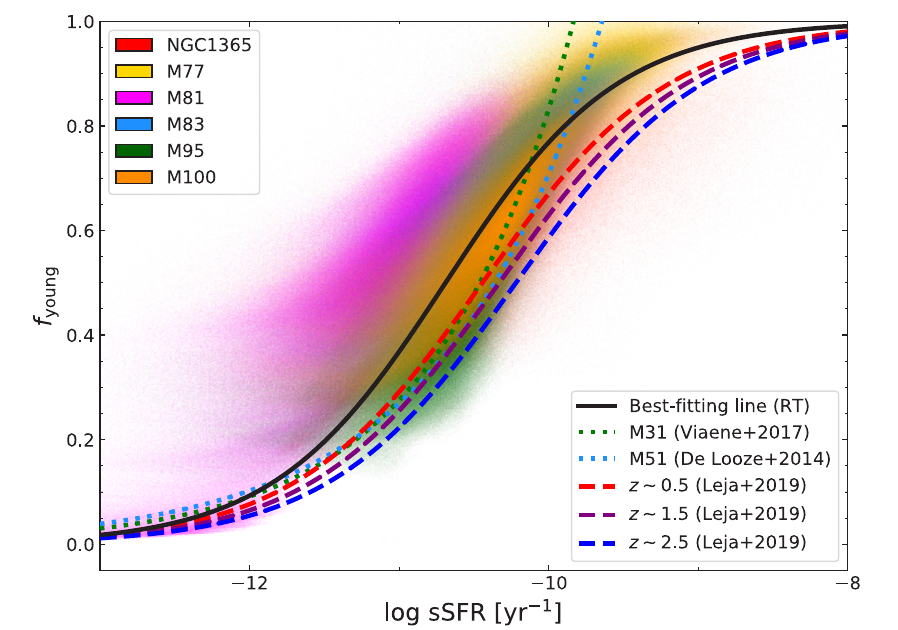
Figure 3. The relation between the fraction of dust heating by young stars and the specific star formation rate of galaxies. Image Credit: